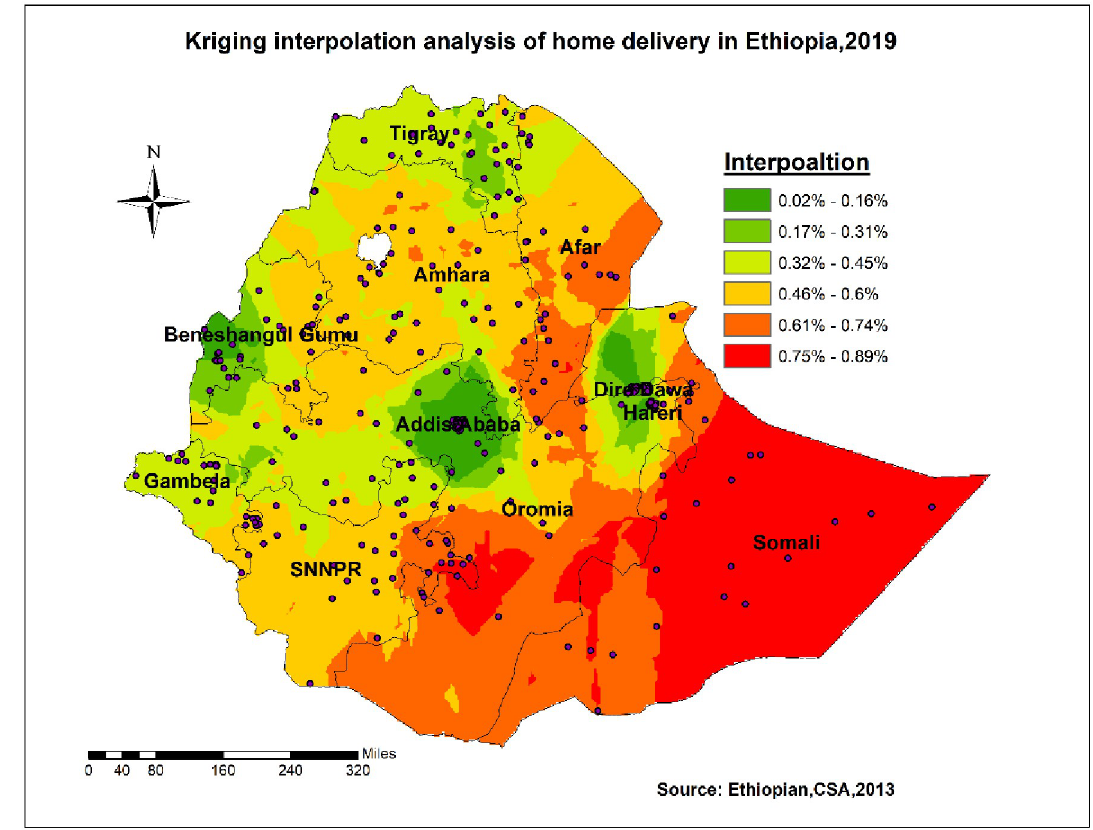
Fig 5. Ordinary kriging spatial interpolation of home delivery in Ethiopia,